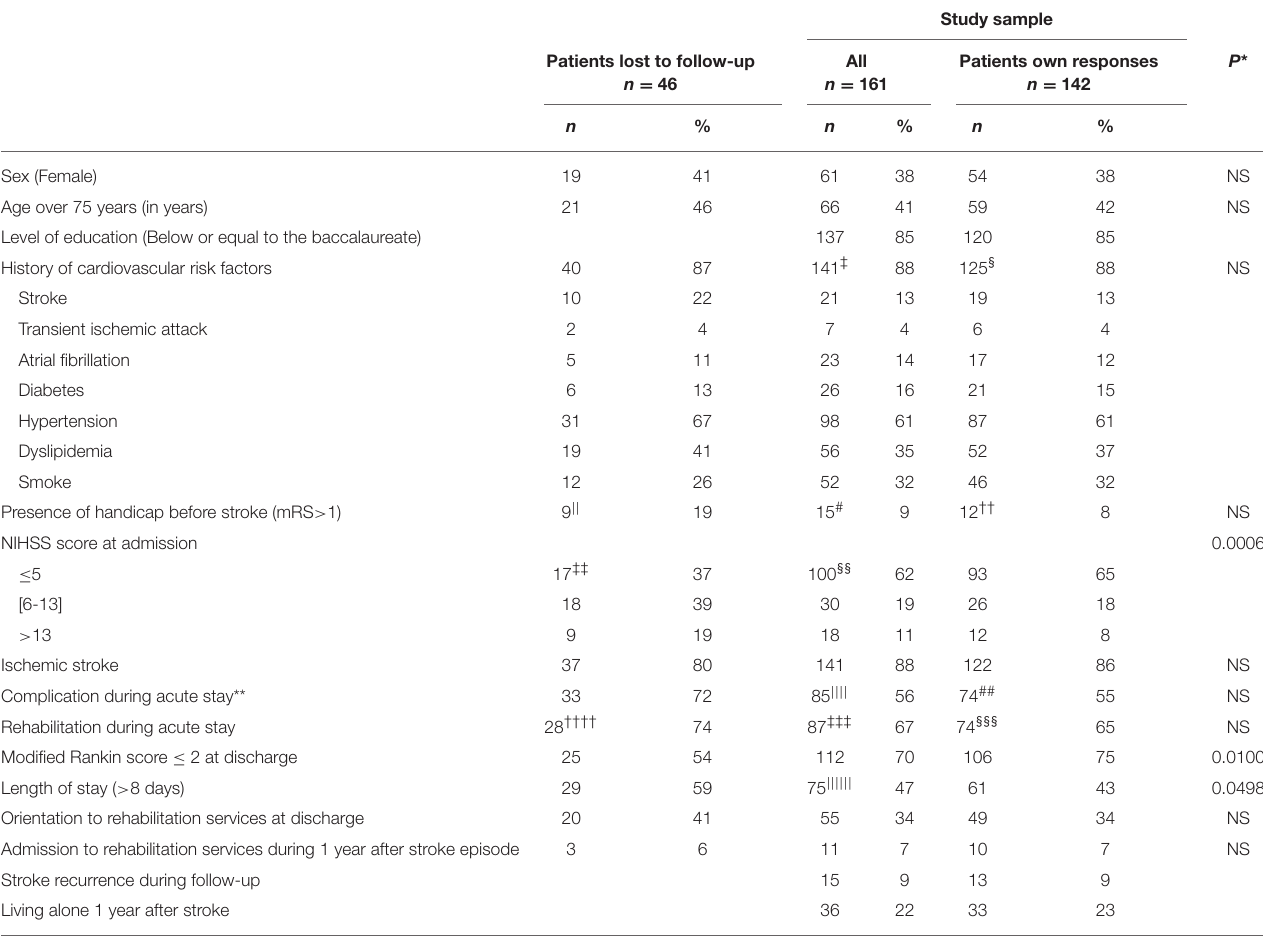
TABLE 1 | Socio-demographic and clinical characteristics: study sample, patients